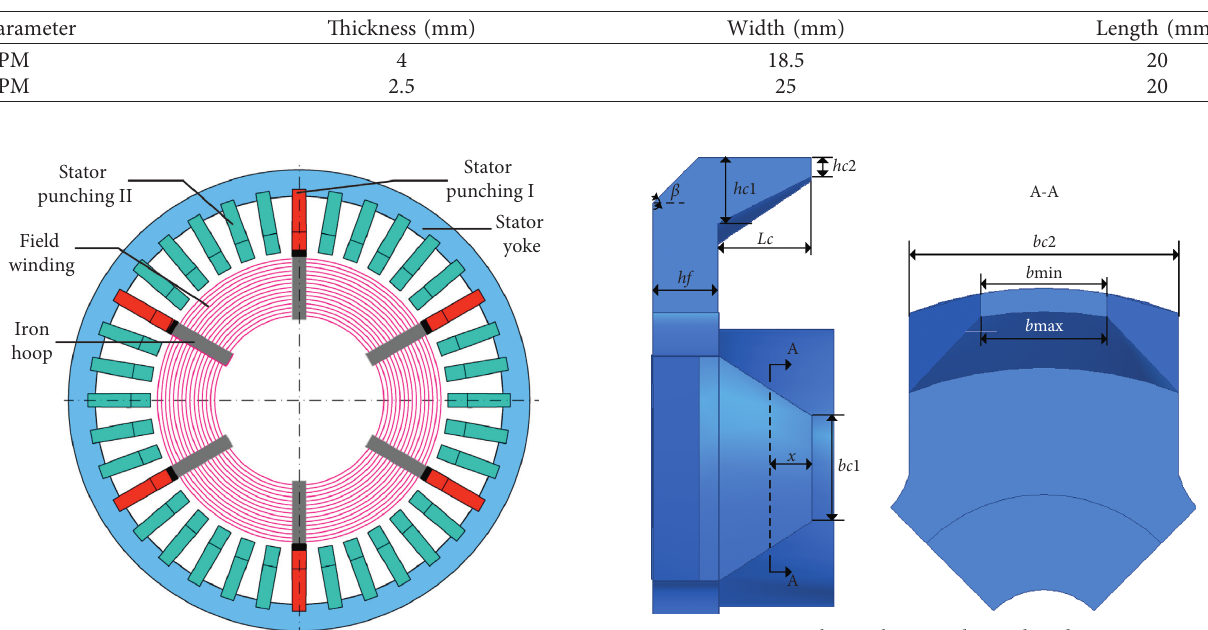
Figure 4: The combined PMR. (a) The structure of combined PMR. (b) The electromagnetic parameters of combined PMR. Table 2: Structural dimensions of the combined PMR.